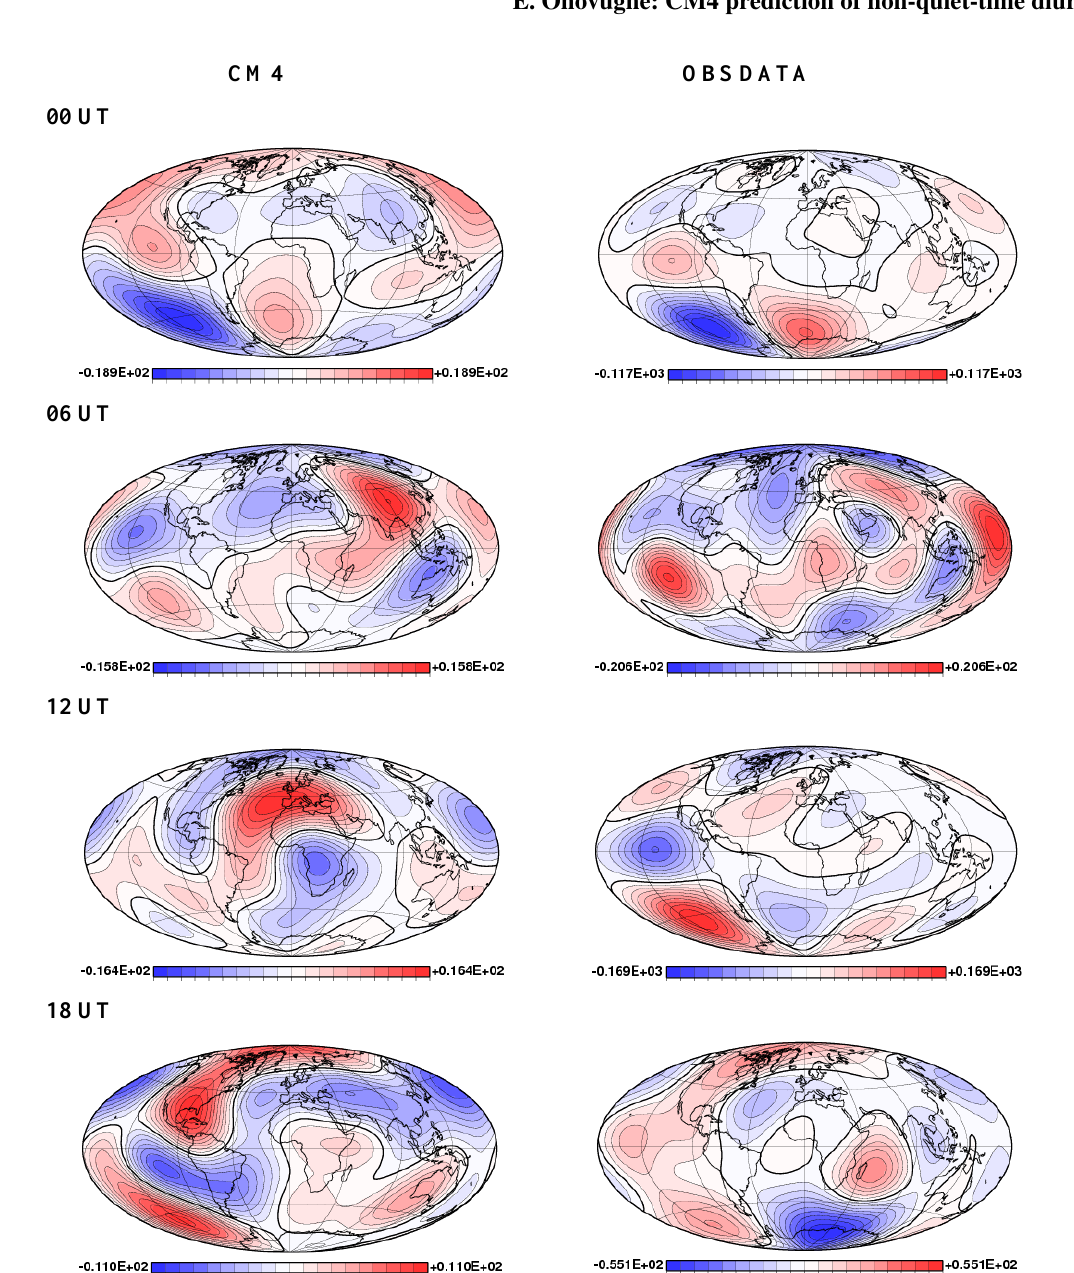
Figure 7. Similar to Fig. 5 but for spherical harmonic degree truncation up to 5, n = 5. More small-scale features start to